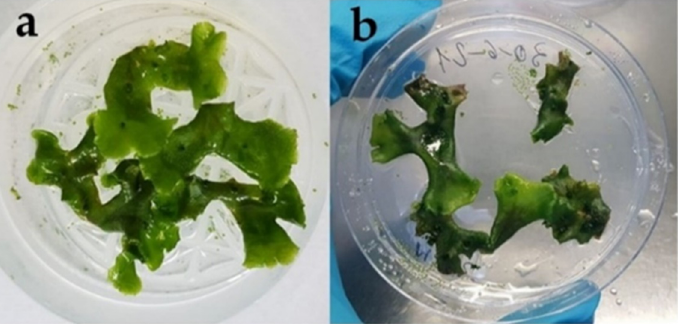
Figure 2. M. polymorpha growth after 2 weeks in liquid ( a ) and solid ( b ) MS 1 / 2 medium, supplied with sucrose.